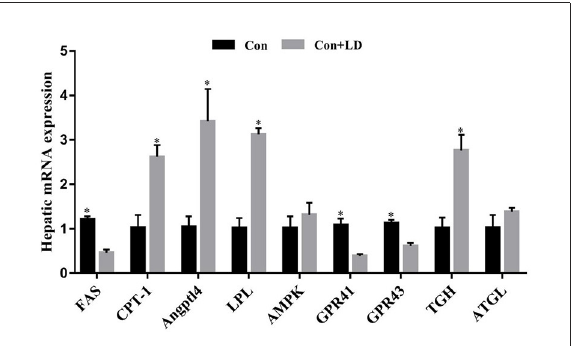
FIGURE4 Hepatic gene expression related to lipid metabolism of growing-finishing pigs. Values for histogram are shown as Mean ± SEM, * P < 0.05. FAS , Fatty acid synthetase; CPT1 , Carnitine palmitoyltransferase 1; Angptl4 , Angiopoietin-like protein 4; LPL = Lipoprotein lipase; AMPK = Adenosine monophosphate activated protein kinase; GPR41 , G protein-coupled receptor41; GPR43 , G protein-coupled receptor43; TGH , Triglyceride hydrolase; ATGL , Adipose triglyceride lipase; Con = basal diet; Con + LD, basal diet + 0.1 % L. delbrueckii .